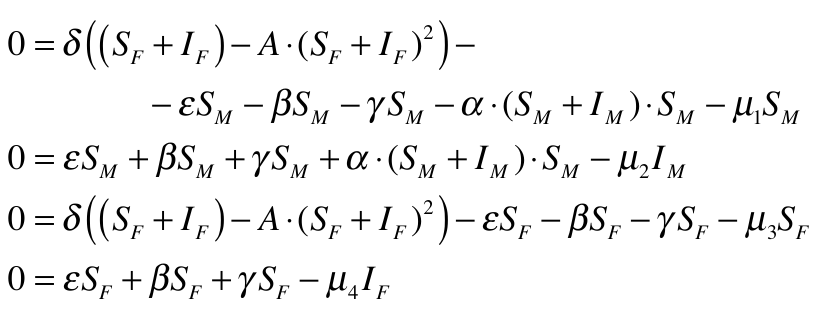
Figure 4. The system of differential equations at